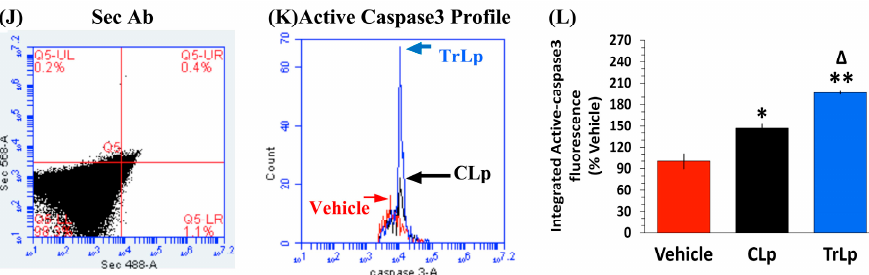
Figure 7. Short-term treatment of GBM mice with TrLp and CLp causes suppression of GBM stem cells and apoptosis of GBM cells. ( A – L ) Dispersed GBM tumor cells from five-day-treated mice of the three groups were stained with antibodies against CD133 and analyzed by flow cytometry. ( A , E , F ) The Vehicle-treated mice showed a number of CD133(+) GBM stem cells (UL, within the red ellipse); ( A – C , E , F ) Relative to Vehicle-treated, the CLp-treated mice showed a 92% suppression of CD133 IF (* p = 0.03) and the TrLp-treated samples displayed a 99% suppression of CD133 IF (** p = 5.0 × 10 − 3 ) ( E , F ); ( B ) 2 ◦ antibody-treated samples showed background staining; ( G – L ) Dispersed cells double-stained for CD68 and Active-Caspase3 showed two discrete populations: CD68 high , Active-Caspase3(+) (apoptotic GBM cells, UR within the red rhombus) and CD68 high , Active-Caspase3( − ) (non-apoptotic GBM cells, LR within blue circles) [14,22]; ( G , K , L ) A few of the Vehicle-treated CD68 high GBM cells are Active-Caspase3+ (within red rhombus), but a large number were Active-Caspase3( − ) cells (non-apoptotic, LR within blue circle); ( G , H , K , L ) CLp treatment caused a 47% increase in Active-Caspase3 IF ( K , L ) of CD68 high , Active-Caspase3(+) cells (apoptotic, UR within red rhombus) (* p = 0.04; versus Vehicle-treated), along with a decrease in the number of CD68 high , Active-Caspase3( − ) cells (LR, blue circle); ( G , I , K , L ) TrLp treatment caused a 96% increase in Active-Capsase3 IF ( K , L ) of CD68 high cells (** p = 0.04, TrLp versus Vehicle-treated) along with a further decrease in CD68 high , Active-Caspase3( − ) cells (LR, blue circle). In contrast, the levels of the CD68 low cells shown by black arrows (likely TAM) did not change appreciably; ( K , L ) This increase in Active-Caspase3 in the TrLp group was 49% greater than in the CLp-treated ( Δ p = 0.02). Data (mean ± S.E.M.) obtained from Vehicle ( n = 3 mice), CLp ( n = 3 mice) and TrLp ( n = 3 mice); ( J ) 2° antibody-treated samples showed background staining.